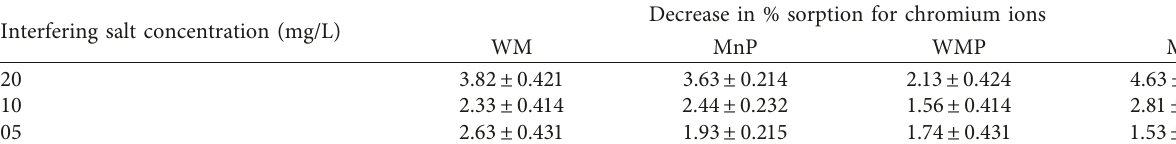
Table 7: Influence of interfering salt NaCl/Na